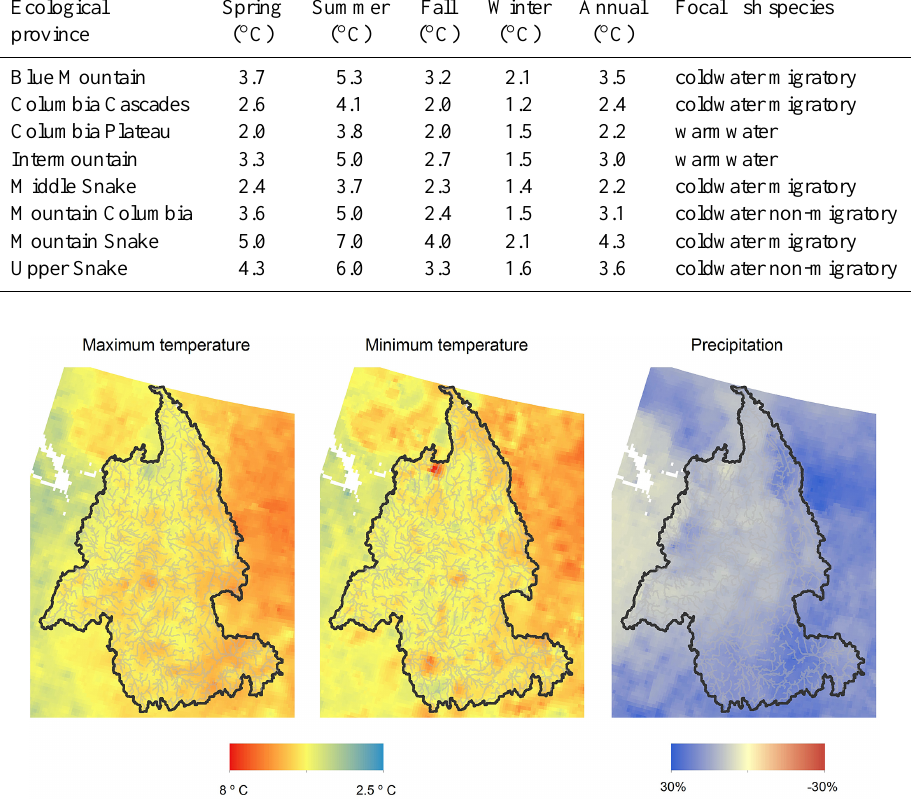
Figure 4. Changes in average precipitation and air temperature (maximum and minimum) for the end of the 21st century as compared to the historical time